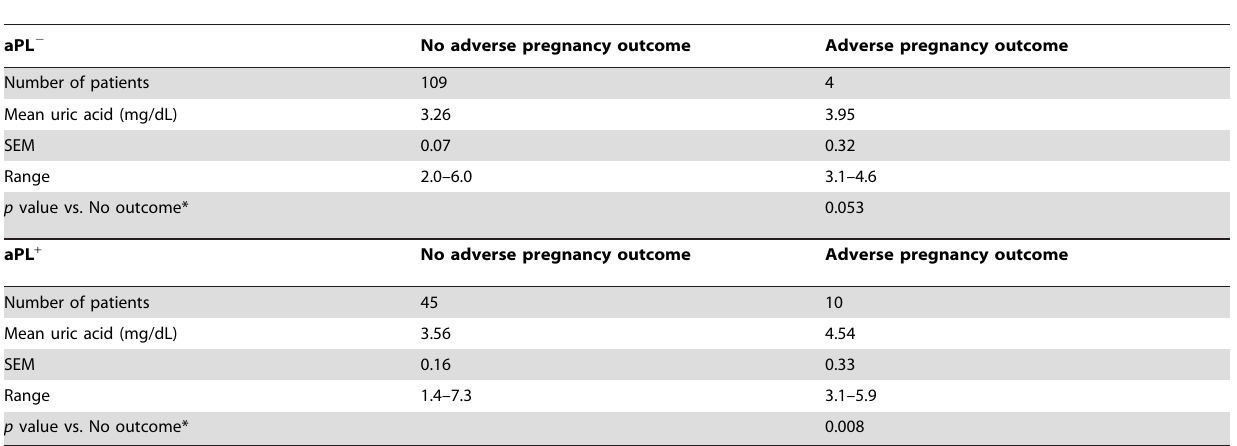
Table 1. Uric acid levels in serum from aPL 2 and aPL + PROMISSE patients at 20–23 weeks gestation.